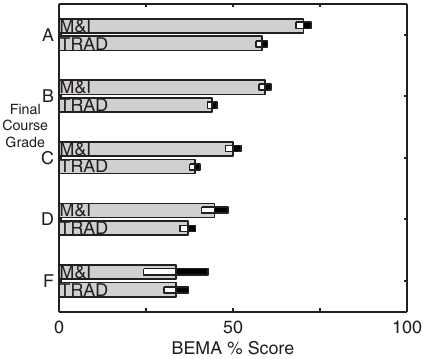
FIG. 6. The average post-test BEMA score of all students re- ceiving a particular final course grade in introductory E&M at GT is shown. The error bounds indicate 95% confidence intervals on the estimates of the average for each grade. The numbers of students for whom grades were obtained are N =1233 for traditional students and N =611 for M&I